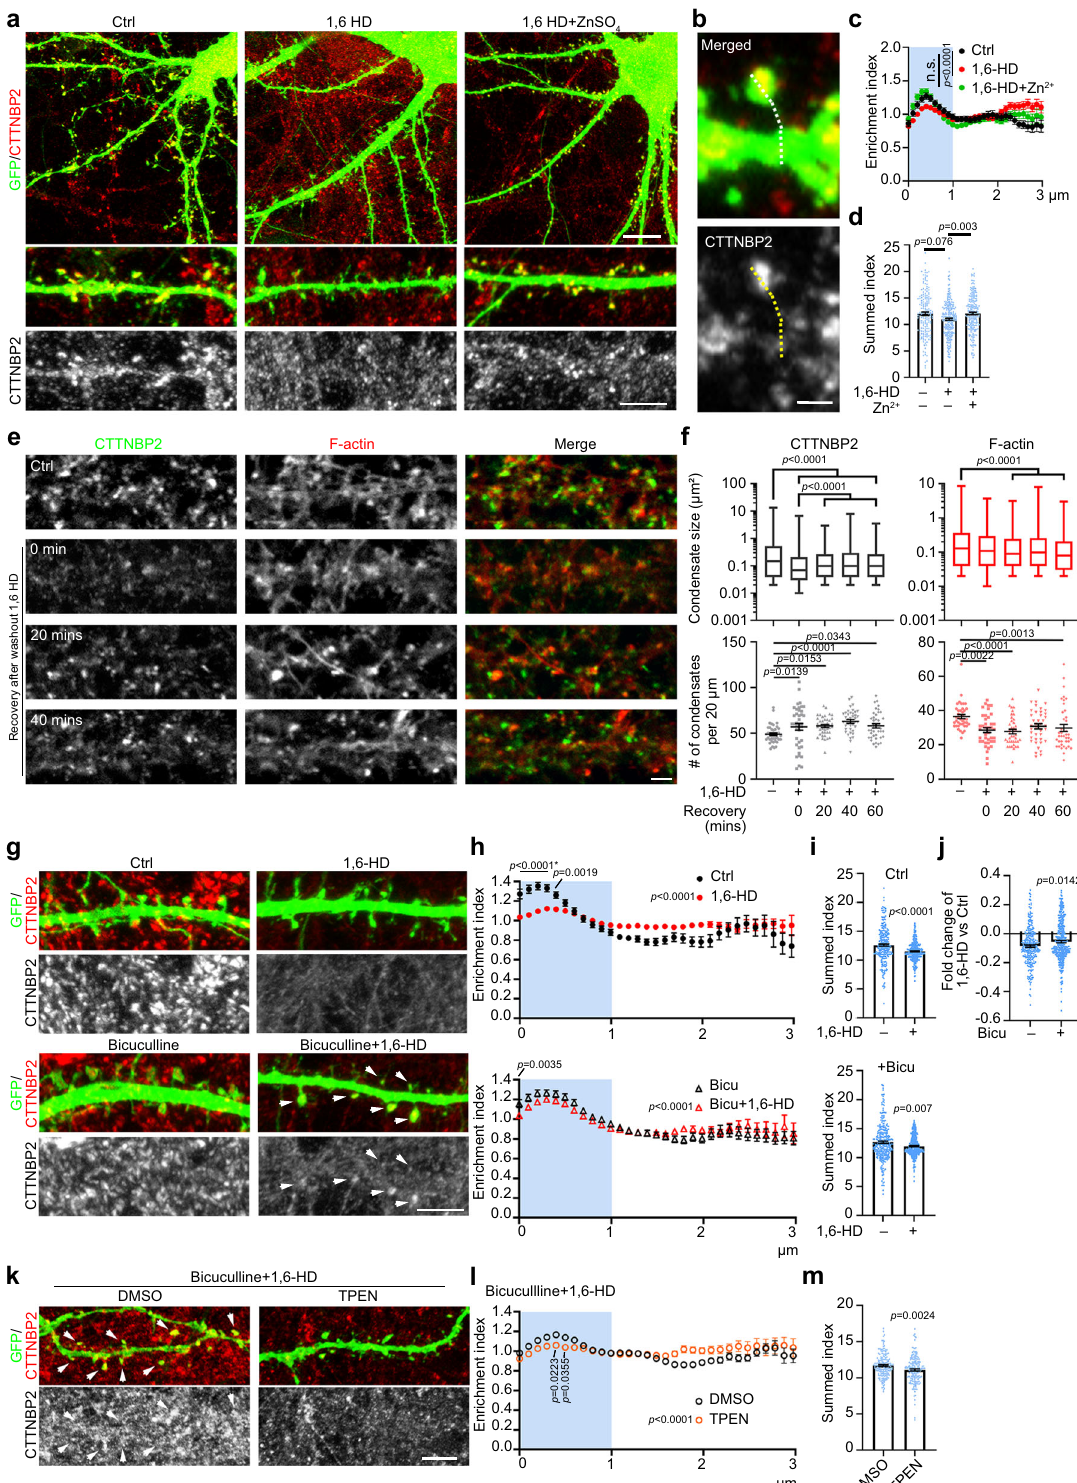
Thus, LLPS is involved in the synaptic distribution of CTTNBP2 and its interaction with SHANK3 in neurons, with synaptic stimulation employing zinc to in fl uence the phase transition and mobility of postsynaptic CTTNBP2 and